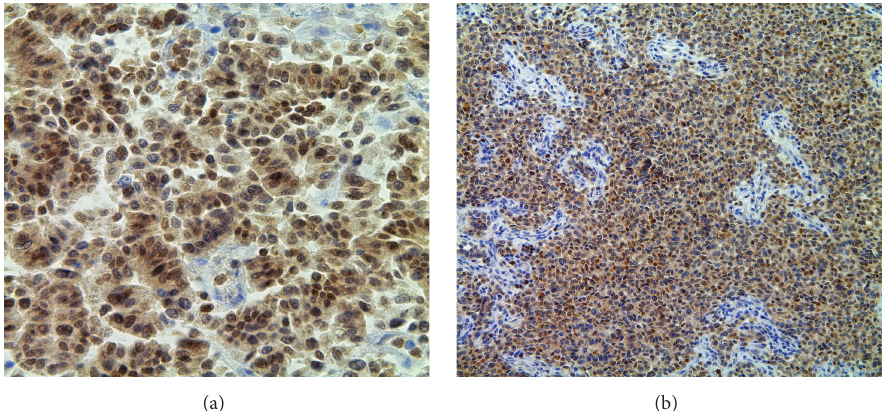
Figure 3: (a) 50x: PAX-8 immunohistochemical stain depicting diffuse nuclear staining in the papillary component of the tumor. (b) 20x: PAX-8 immunohistochemical stain in the solid component of the